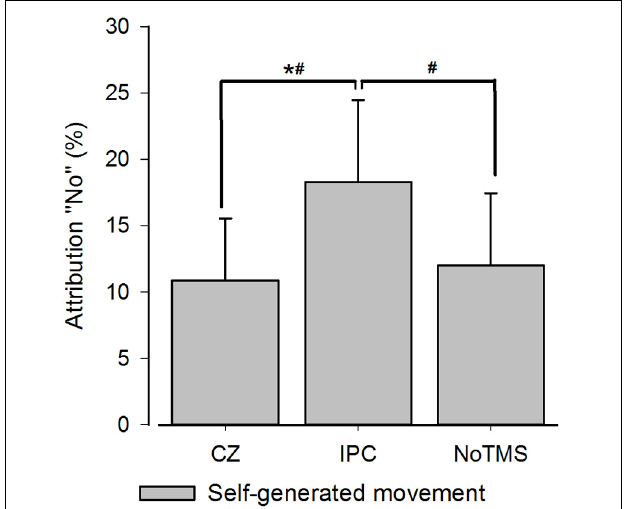
FIGURE 2 | Group averages for SoA for self-controlled movements. The figure displays the group averaged level of agency rejection in percentage for self-controlled movements. The ∗ indicates a significant difference when corrected for Holm-Sidak post-hoc test. The # identifies a significant p -value prior to the Holm-Sidak correction. Error bars depict inter-subject